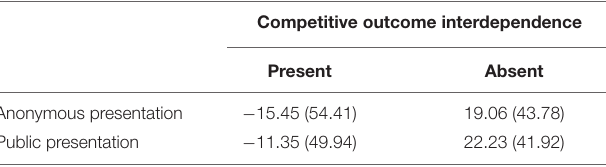
TABLE 2 | Mean difference scores of members according to competitive outcome interdependence and results